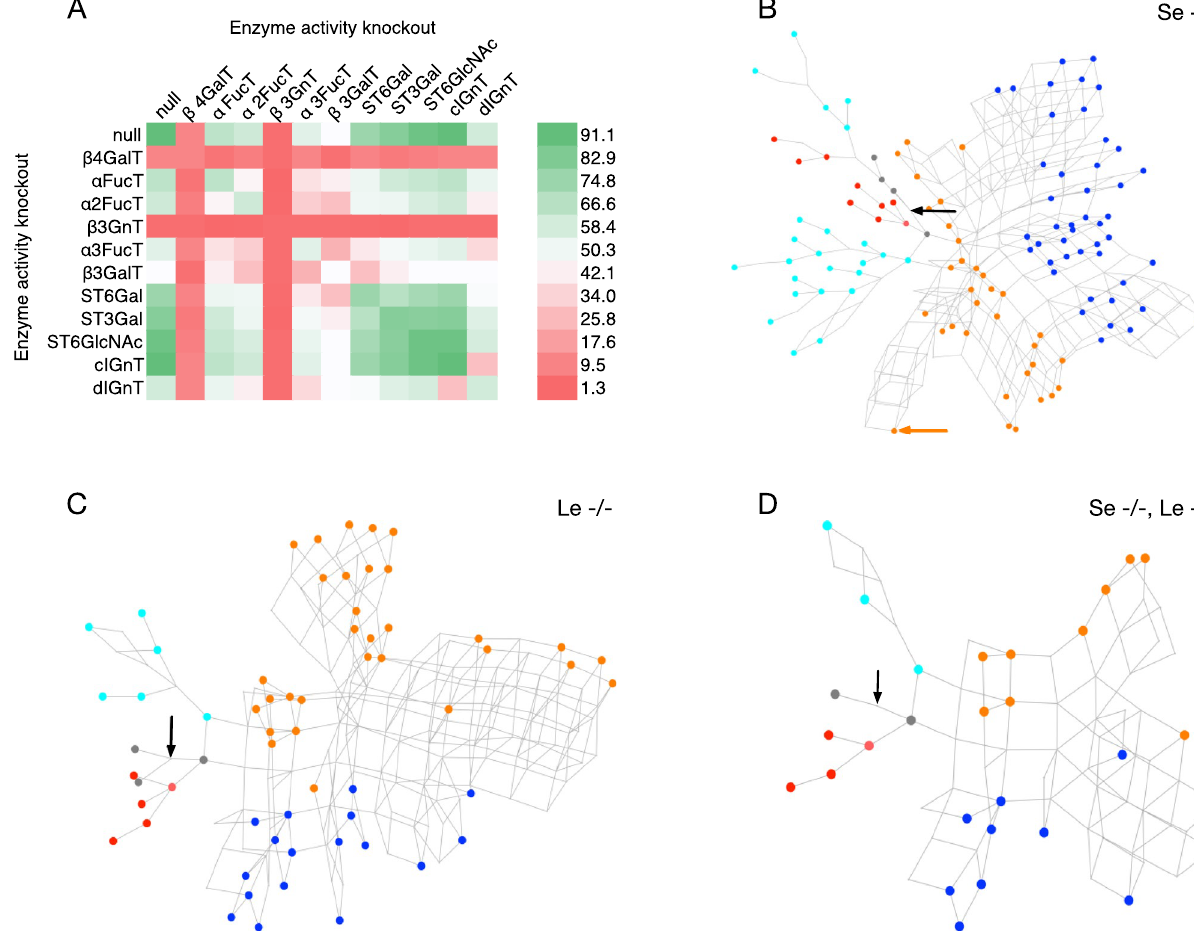
Figure 8. Simulated knockouts of the enzyme activities. ( A ) Effects of dual knockouts of the activities in Table 2 on the percentage coverage of the HMO structure library (Supplementary Table S1). In the null/null knockout all enzymes remain active. Colours range from purple (minimal coverage: 1.3%) to yellow (maximal coverage: 91.1%), corresponding to the null/null knockout ( 0 / 0 ) and the α4FucT/β3GnT knockout ( 2 / 4 ), respectively. ( B – D ) Predicted HMO biosynthetic networks of (B) non-secretor (Se-/-), (C) Lewis-negative (Le-/-) and (D) non-secretor/Lewis-negative mothers. Observed HMOs are coloured according to their base-core value (Fig. 1): magenta (1/1), blue (2/1), green (1/2), orange (2/2), red (1), cyan (2), grey (other/unclassified). In each network the position of lactose is indicated by a black arrow. In the Se-/- network (B), an orange arrow indicates the position of inverse